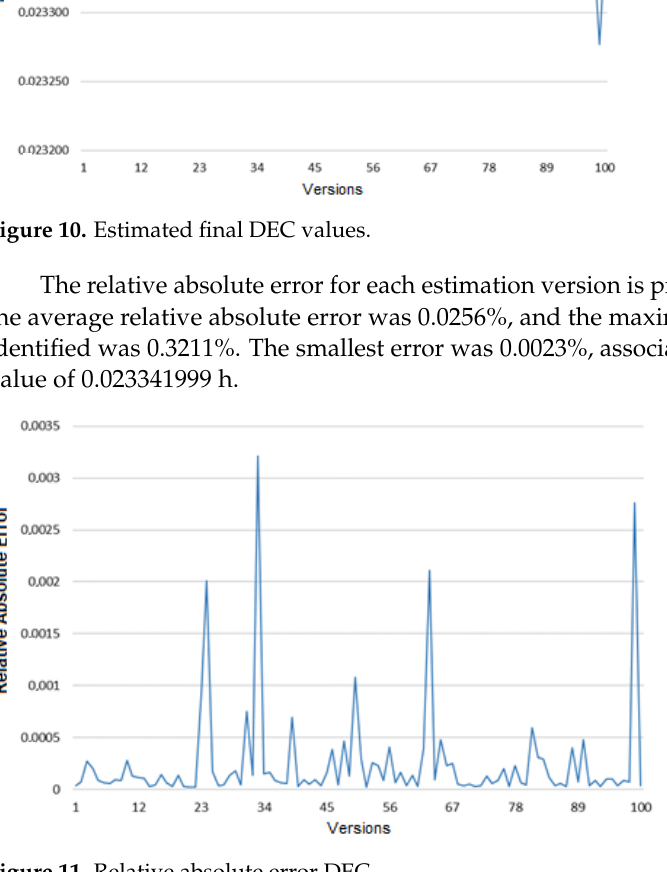
Figure 11. Relative absolute error DEC.